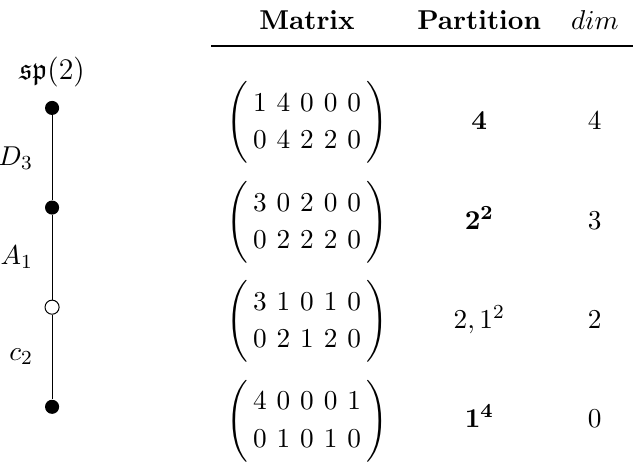
Table 20. Results obtained applying the matrix formalism to sp (2).